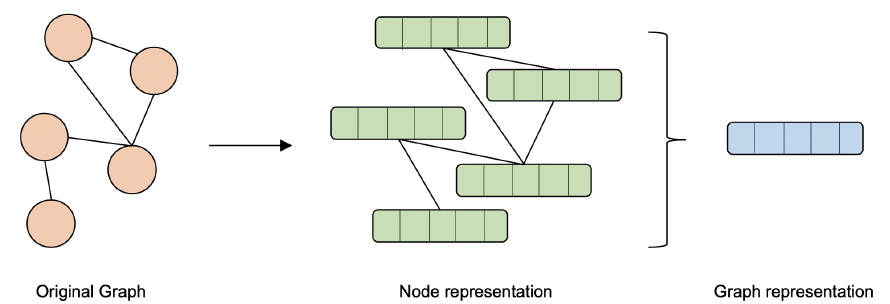
Figure 6. An example of node and graph representation. Here the node representation vectors are aggregated to generate a single graph